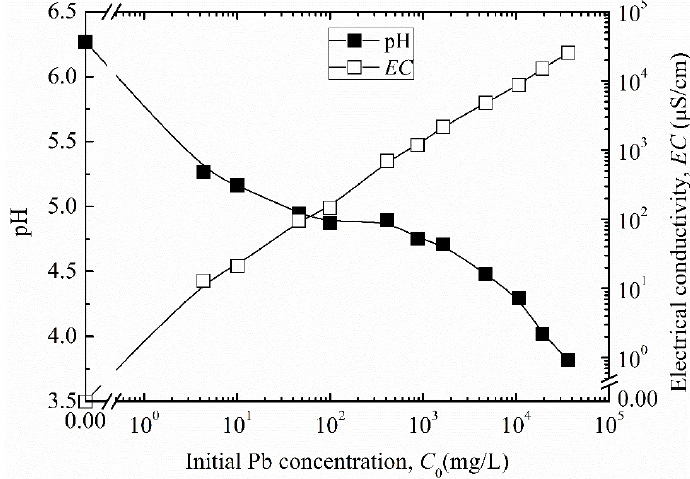
Figure 3. pH and electrical conductivity ( EC ) of the Pb solutions at different initial concentration.